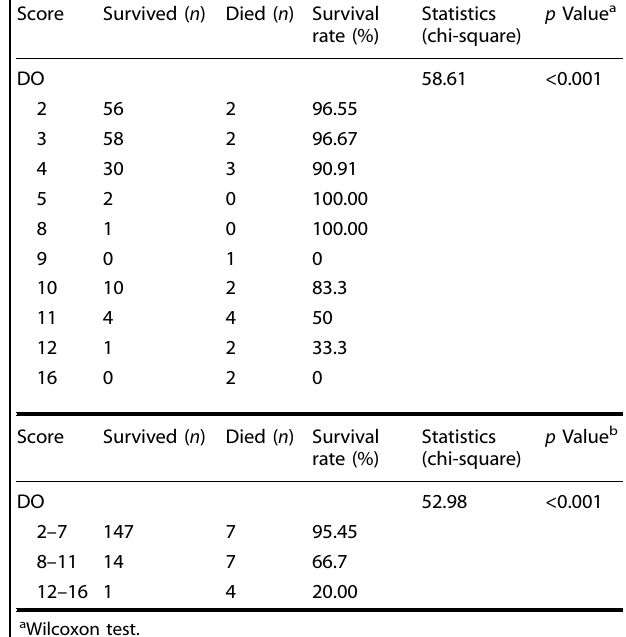
Table 3. Weighting of variables in DO index. Table 4. Survival analysis of 1-year mortality for different DO index scores of patients with severe and very severe COPD ( n =